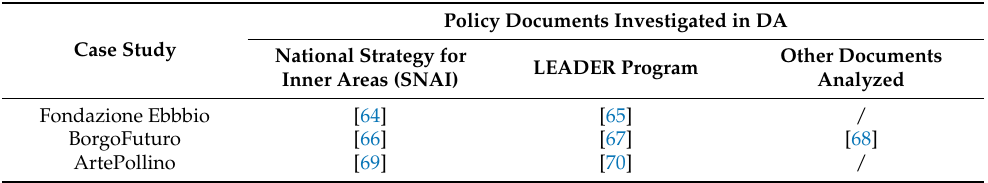
Table 2. Policy and strategic documents investigated through DA. Source: elaboration by the